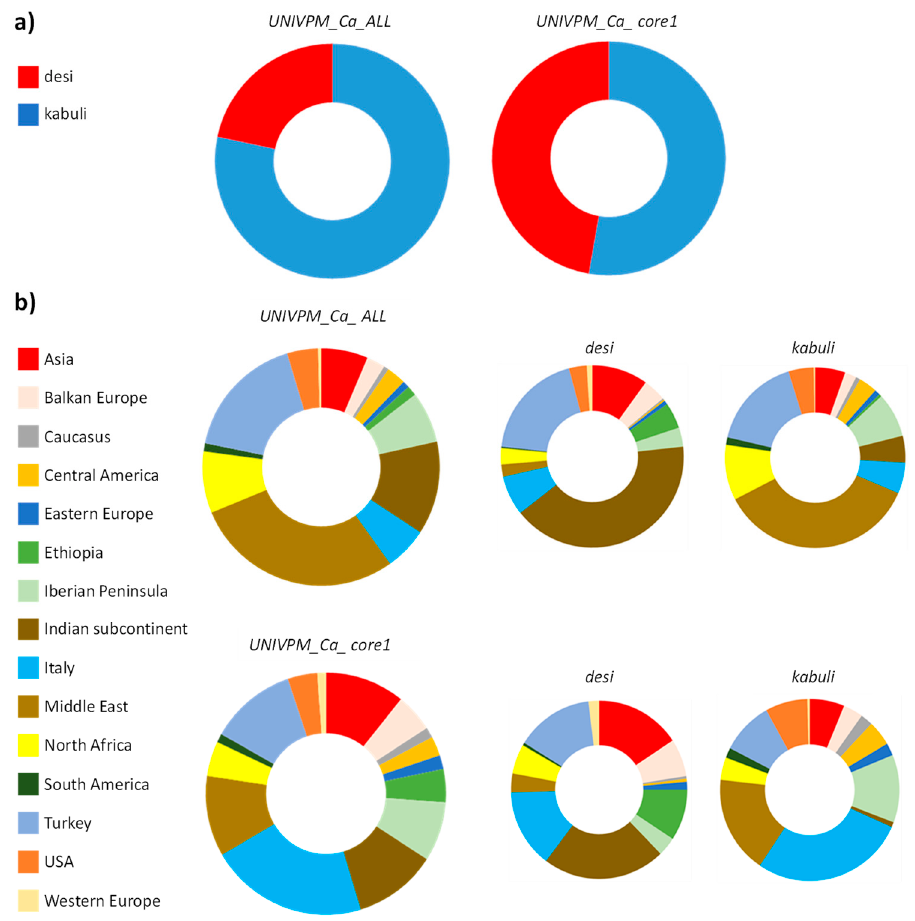
Figure 2. Comparisons of the UNIVPM_Ca_ALL and UNIVPM_Ca_core1 sets of materials; ( a ) Proportions of the desi and kabuli accessions; ( b ) Proportions of the accessions for each geographic area and for the desi and kabuli types.